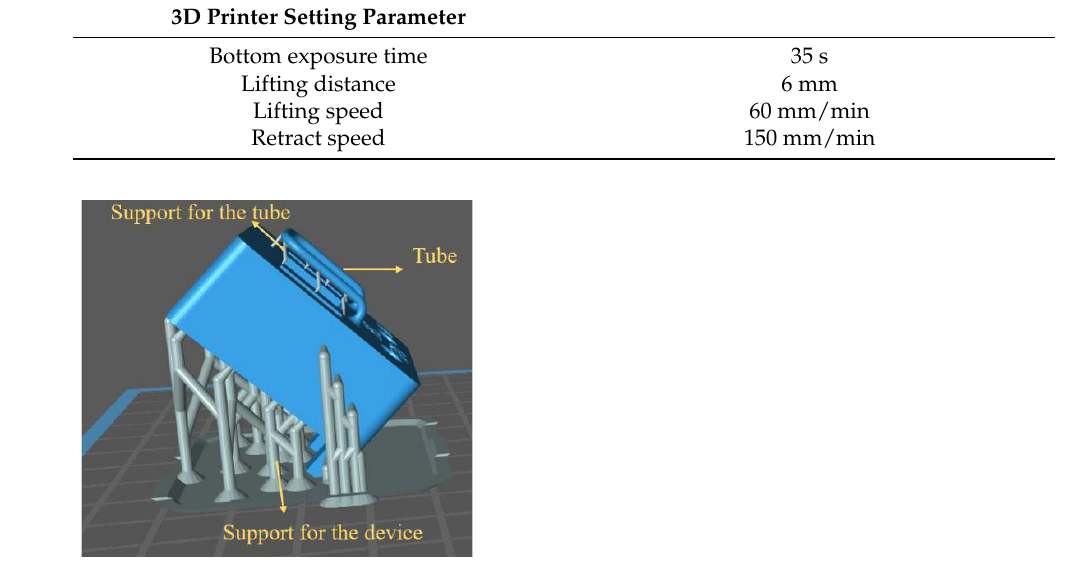
Figure 4. Adjusting the printed device angle to 45 degrees for high-quality printing on the Mini 4K Phrozen printer. Small support structures were added underneath the tube to prevent it from floating inside the resin during printing.